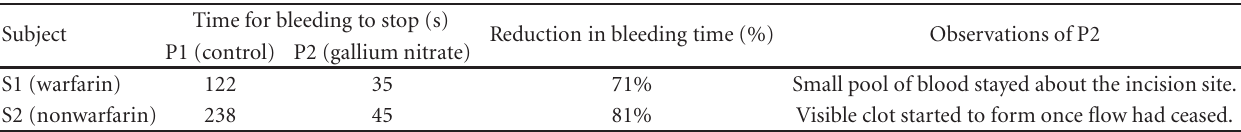
Table 1: The e ff ect of gallium nitrate in reducing bleeding times from simple punctures (P1 and P2) in both warfarin- and nonwarfarin- treated subjects (S1 and S2), with